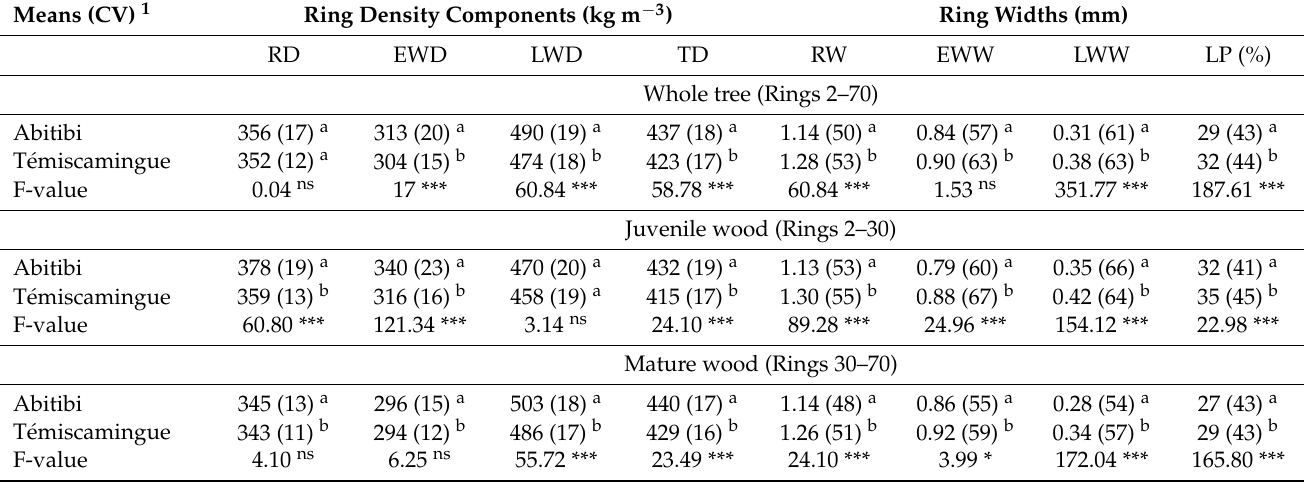
Table 3. Regional comparison of ring density components and ring widths for the whole tree and juvenile and mature wood at breast height in Thuja occidentalis in the Abitibi-T é miscamingue, Quebec,